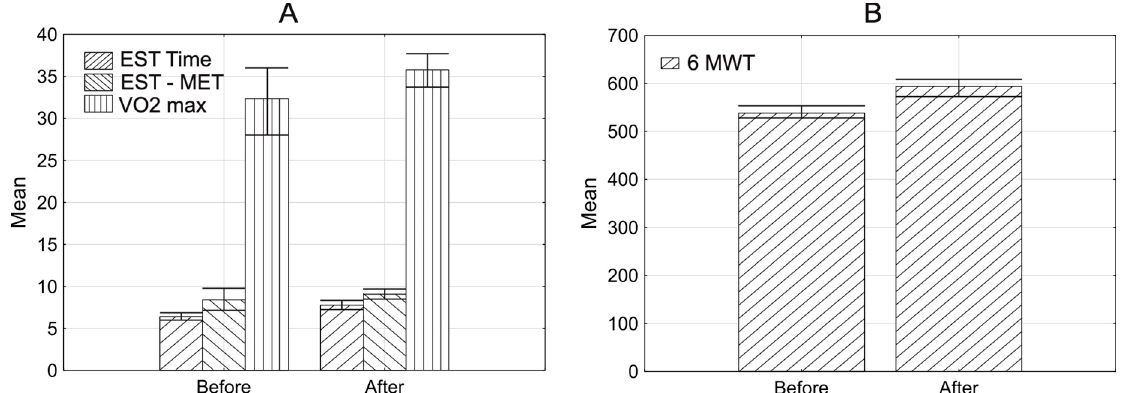
Figure 2. Characteristics of examined group with error bars. Mean before and after rehabilitation in the 2nd phase of rehabilitation. ( A ) Exercise stress test time (EST time), exercise stress test MET (EST MET), VO2max. ( B ) 6MWT; p < 0.05.